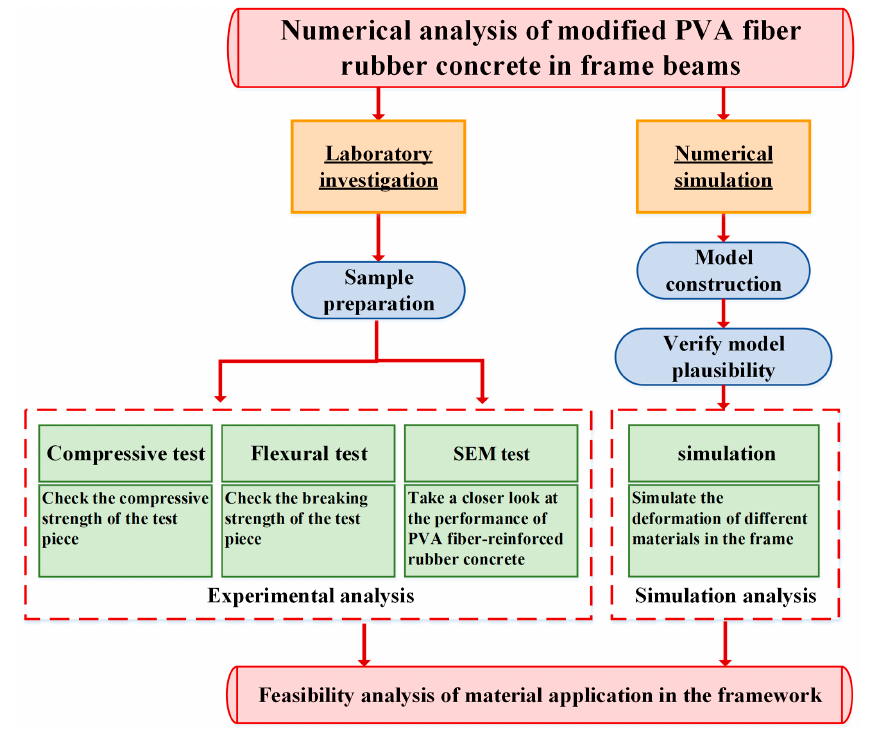
Figure 1. Flow research framework.